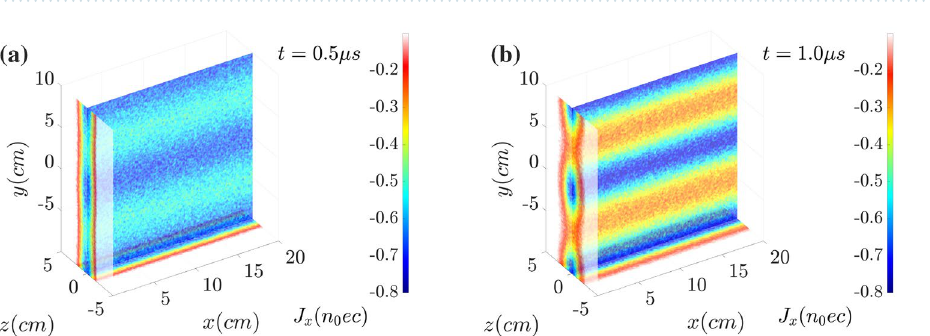
Figure 4. Distributions of magnetic field vectors along x = 0 at ( a ) t = 0.2 µ s , ( b ) t = 0.5 µ s , ( c ) t = 0.7 µ s and ( d ) t = 1.0 µ s . After t = 0.5 µ s magnetic reconnection becomes distinct.